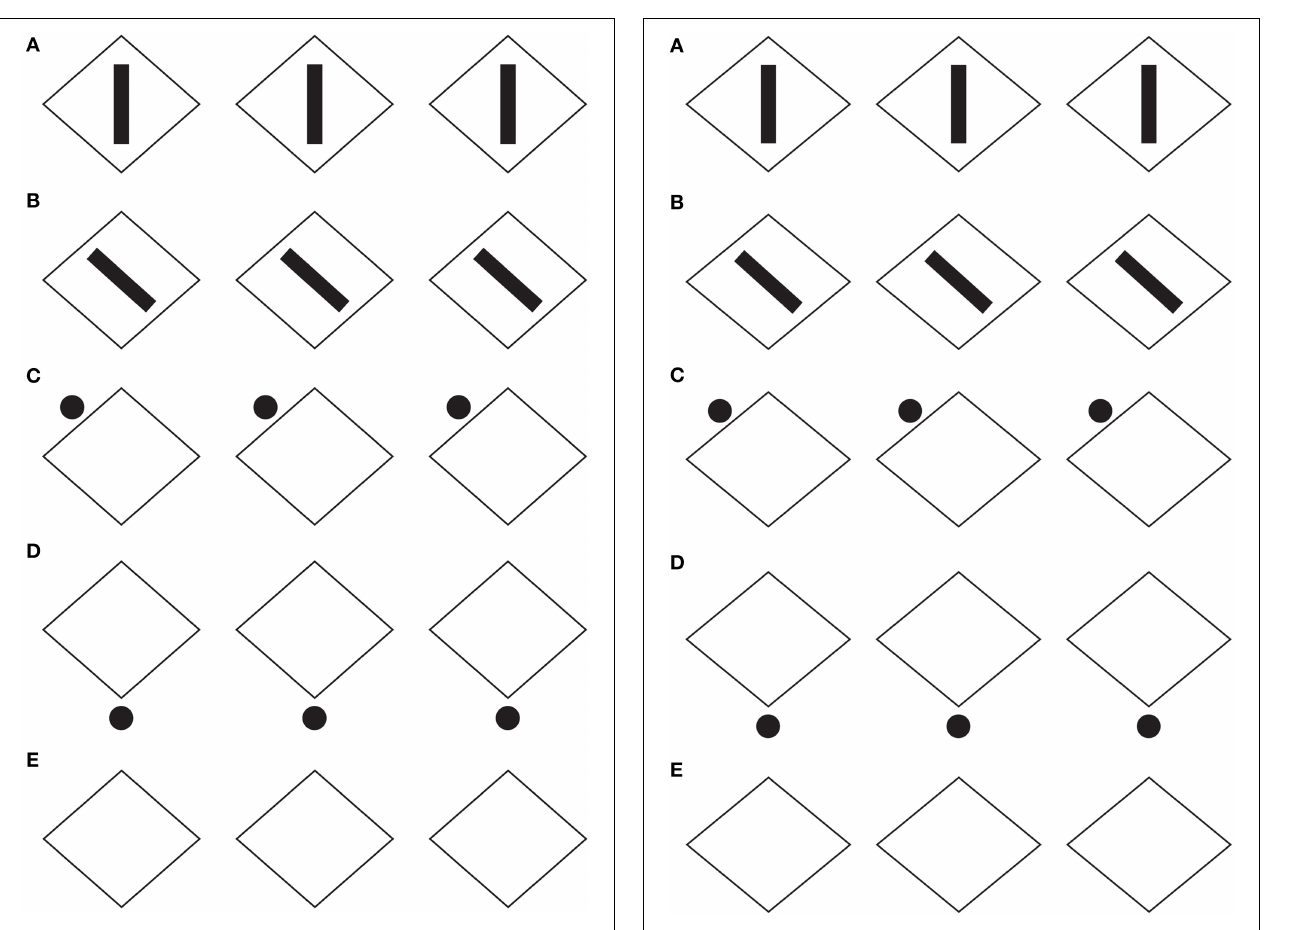
FIGURE 6 | The same results of Figures 4, 5 are also perceived when the length of the horizontal diagonal is further increased. A set of skewed parallelograms are also shown. For further details please see the